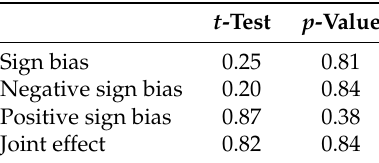
Table A10. Sign bias